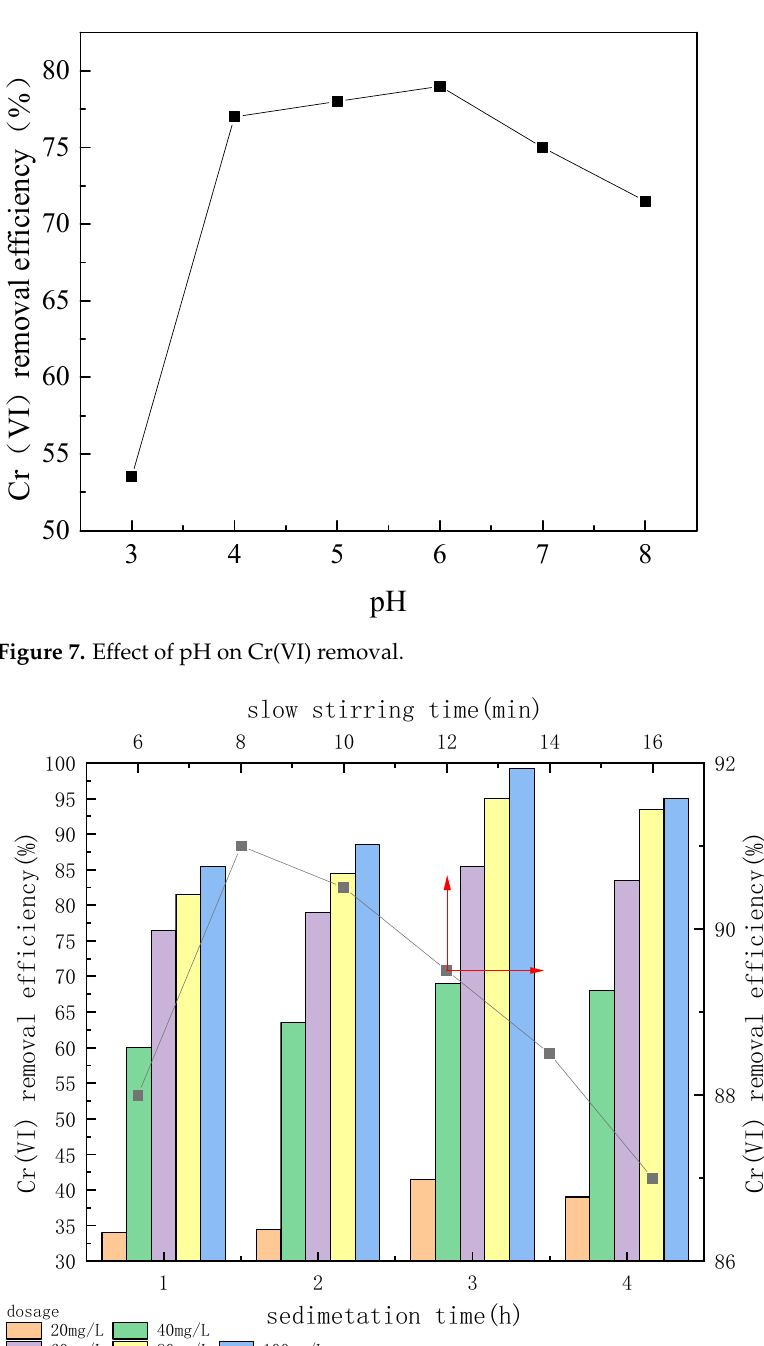
Figure 8. Effect of slow stirring time and sedimentation time on Cr(VI) removal.